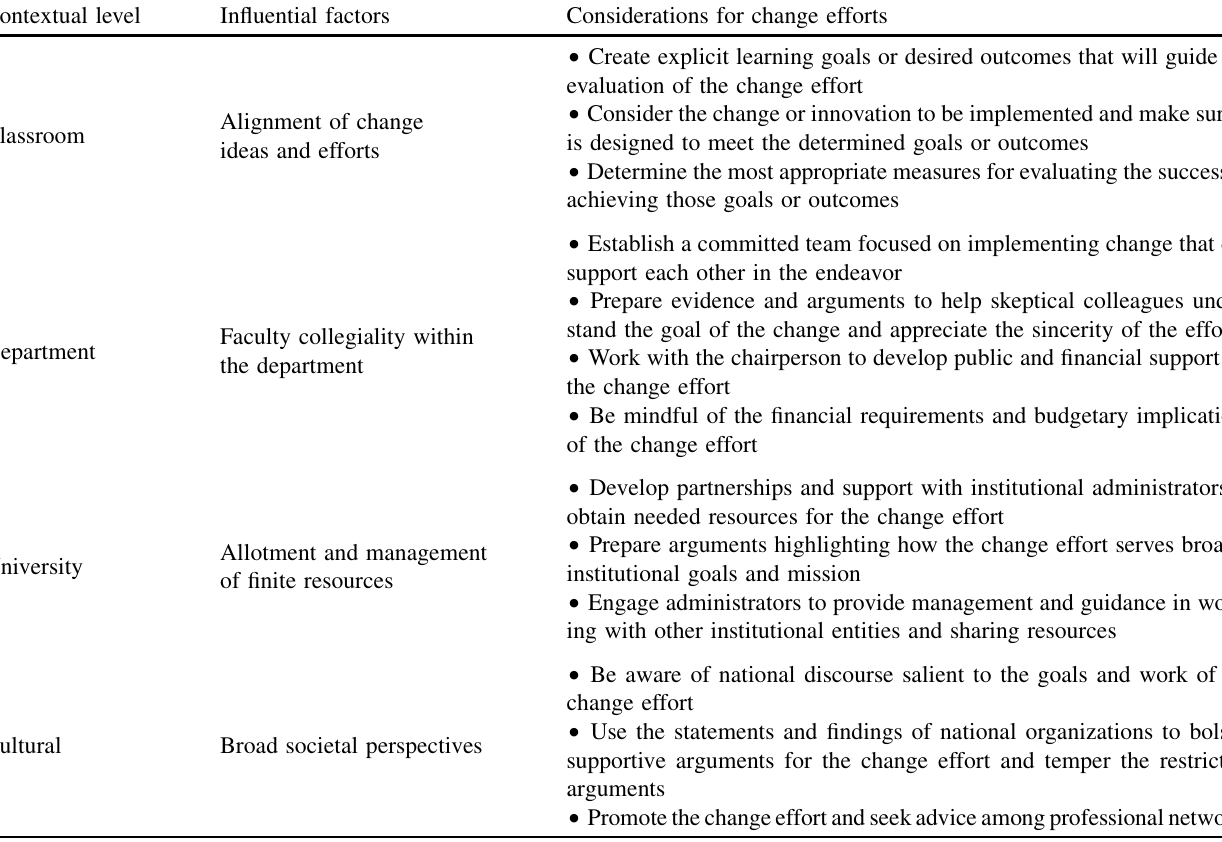
TABLE II. Contextual factors affecting implementation and maintenance of a change effort. Recommendations are based upon evidence drawn from the study, but may not reflect the entirety of approaches available for specific educational